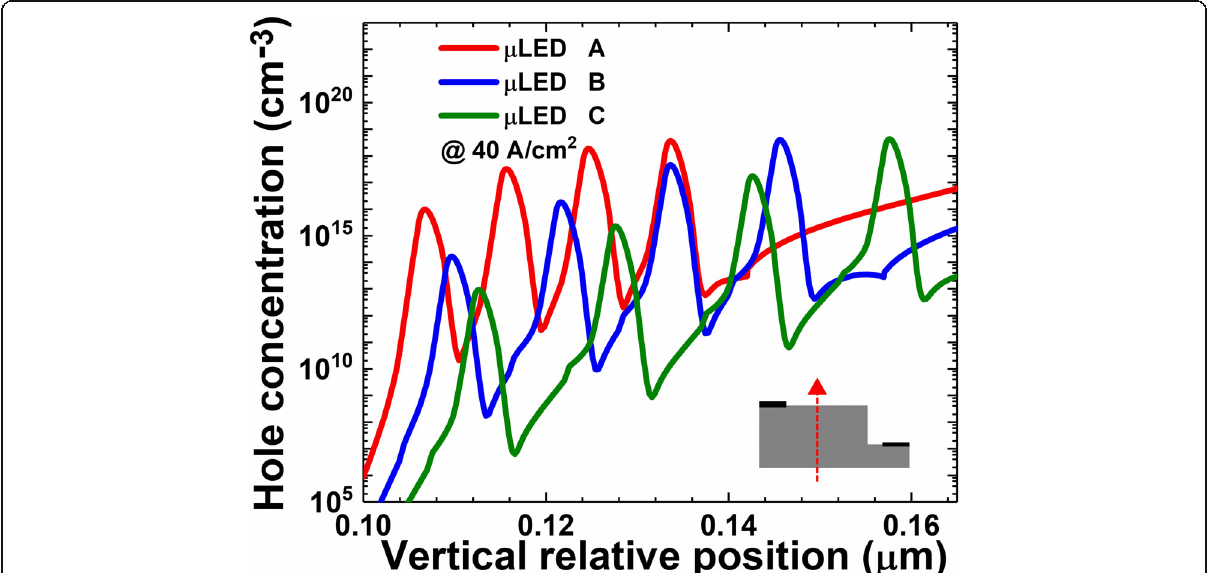
Fig. 2 Numerically calculated hole concentration profiles in MQW regions for μ LEDs A, B, and C. Data are calculated at the current density of 40 A/cm 2 . Inset figure shows the position along which the date profiles are captured